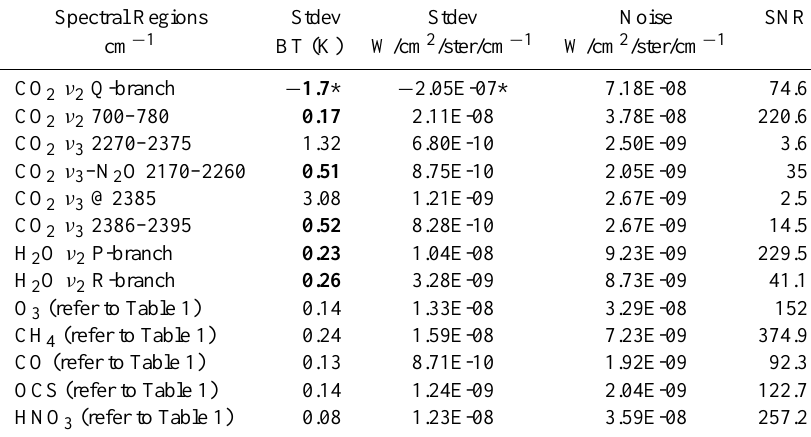
Table 2. Standard deviation (or maximum error) in the retrievals in the defined spectral regions; where regions are not explicitly listed, refer to Table 1 for the spectral windows used. Values are given in brightness temperature and radiance units. The IASI noise level and the total SNR are also provided. It is important to note that the SNR computed here is for the total IASI signal in the spectral regions of interest and not just the signal of species above the background. Numbers in bold are cited in text. Spectral Regions Stdev Stdev Noise SNR cm − 1 BT (K) W/cm 2 /ster/cm − 1 W/cm 2 /ster/cm −